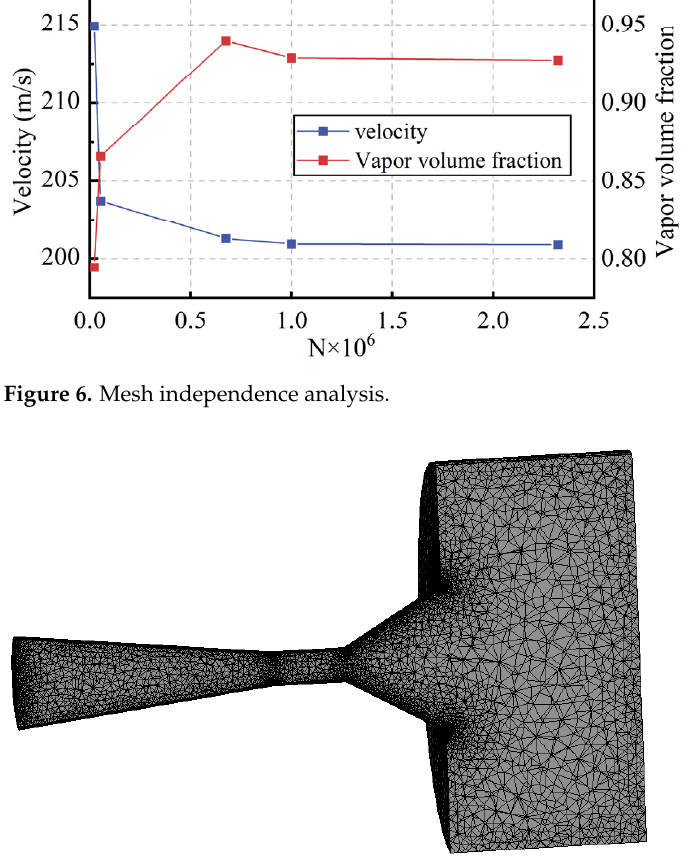
Figure 7. Grid along the z-x plane.